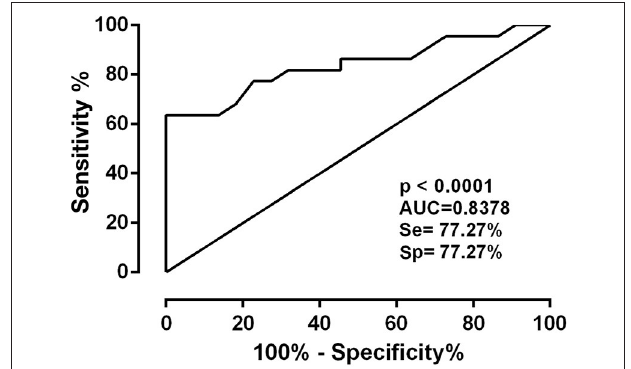
FIGURE 4 | Linear alignment of the amino acid sequences of the four peptides (A6, A8, B6, and D7) with the amino acid sequences of HTLV-1 from various regions of the world available in